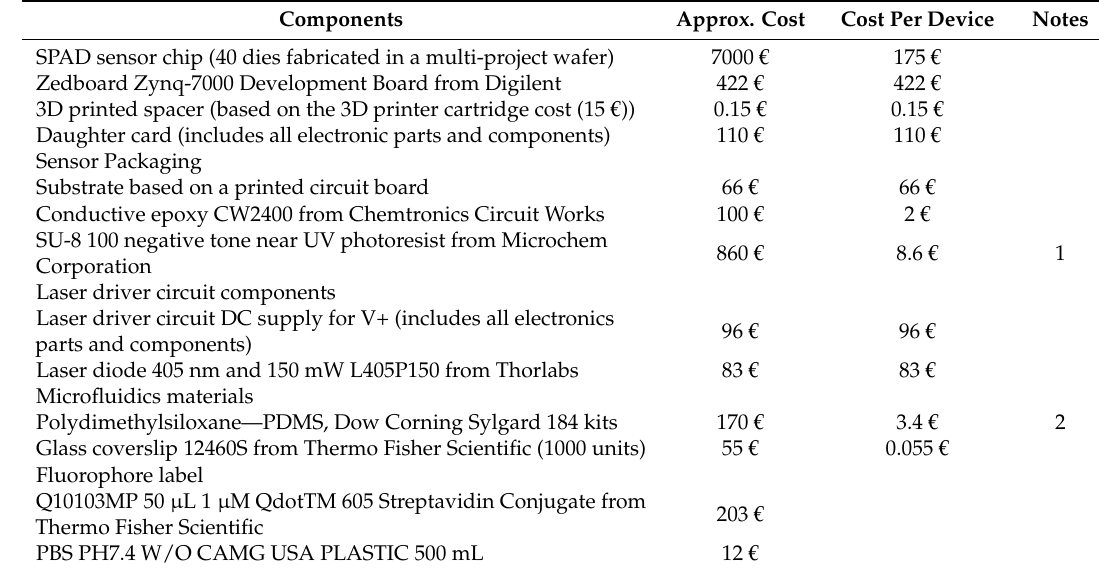
Table 1. The basic components needed to construct the PoC-MD. It is assumed that the computer, 3D printer, and the facilities to perform soft-lithography and wire bonds are available. The costs for raw materials are divided by the estimated number of devices that can be manufactured with